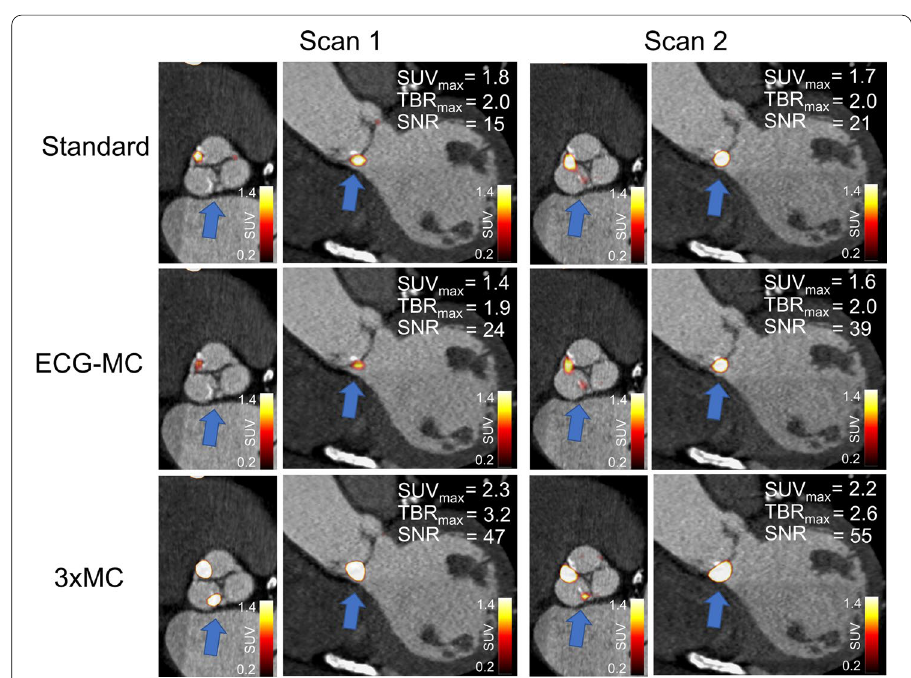
Fig. 8 Test–retest valve PET imaging for a patient before and after motion and background blood pool corrections. Standard and ECG-MC images present lower TBR max , while 3 MC images show higher TBR max × (68% and 30% increase in scan 1 and scan 2, respectively). ECG-MC cardiac contraction motion-corrected, = 3 MC triple motion-corrected, SUV max maximum standardized uptake value, TBR max maximum × = = = target-to-background ratio, SNR signal-to-noise =